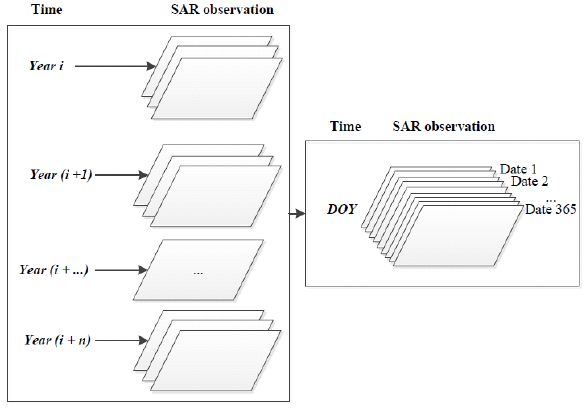
Figure 1. Time series data combination strategy